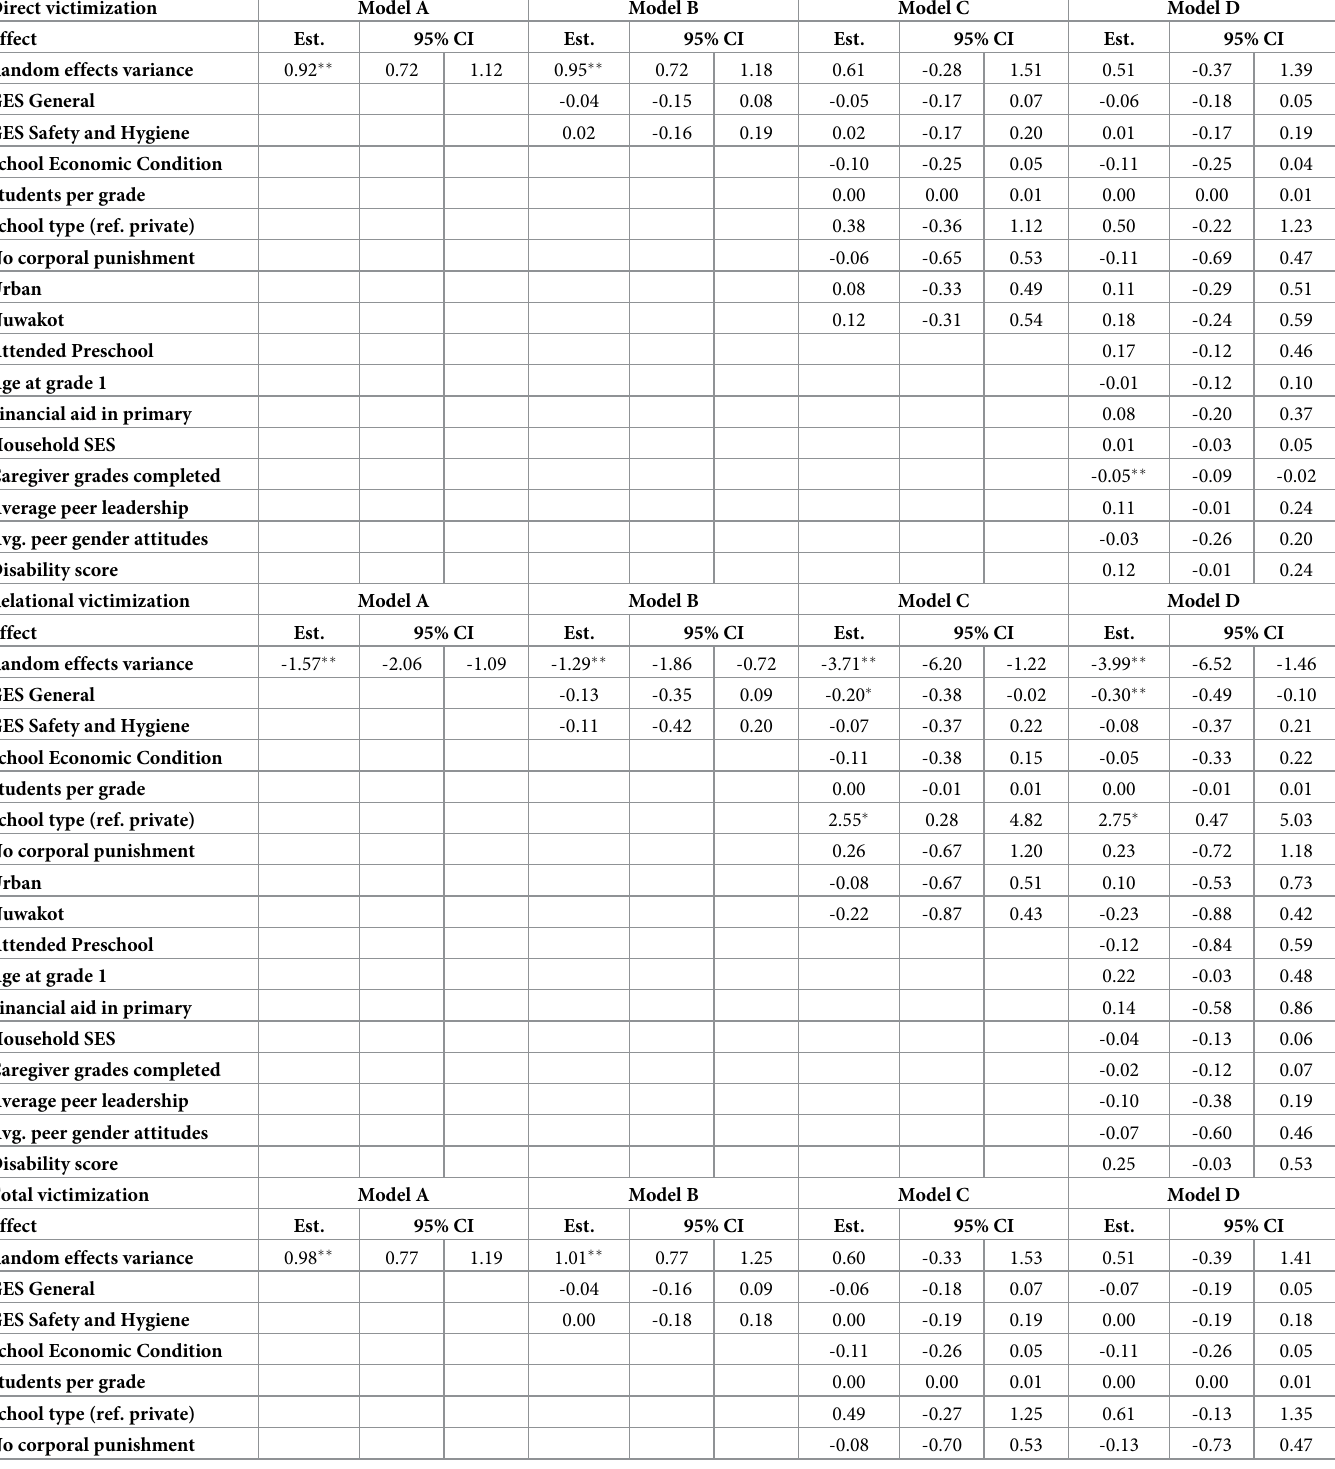
Table 4. Multilevel models of gender equitable school-level exposures and total victimization, N = 729 adolescent girls in Nuwakot and Tanahun districts in Nepal,